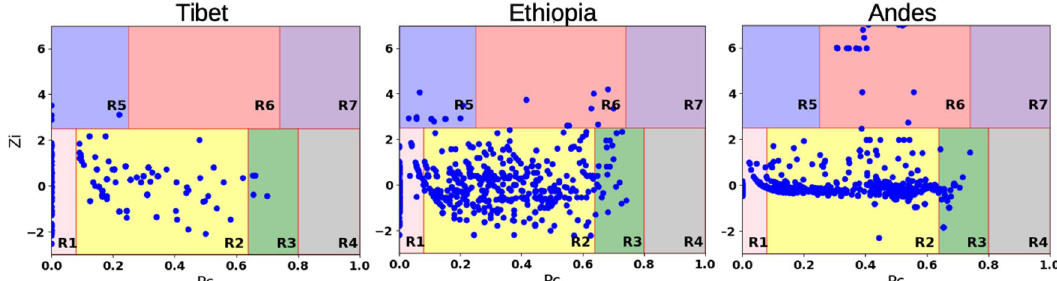
Figure 4. Roles of nodes in Z–P parameter space. Each node in a network can be characterized by its within- module degree and its participation coefficient. Nodes with Z 2.5 were classified as module hubs and nodes with Z < 2.5 as non-hubs. Non-hub nodes can be naturally assigned into four different roles: (R1) ultra-peripheral nodes; (R2) peripheral nodes; (R3)non-hub connector nodes; and (R4) non-hub kinless nodes. Hub nodes can be naturally assigned into three different roles: (R5)provincial hubs; (R6) connector hubs; and (R7) kinless